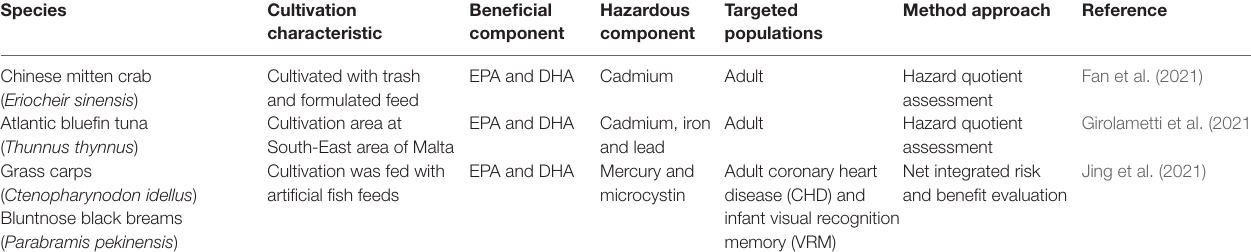
TABLE 4 | Risk and benefit correlation of aquaculture products.